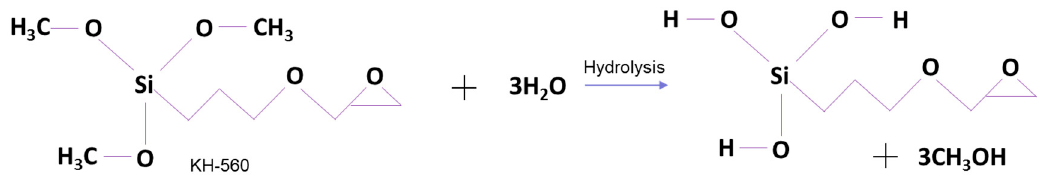
Figure 25. The alkoxide groups (Si–OCH 3 ) of KH-560 are hydrolyzed by water thereby leading to the formation of Si–OH groups and methanol.